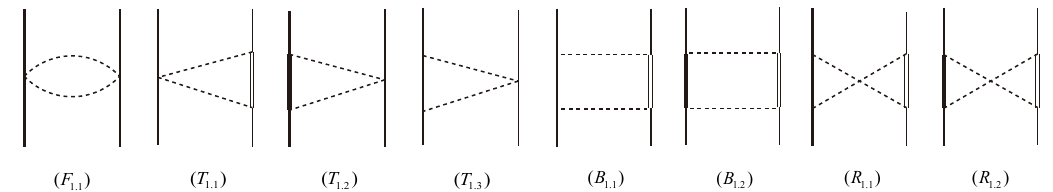
Figure 2 . The leading order Feynman diagrams that account for the O ( " 0 ) e(cid:11)ective potentials of the (cid:6) c (cid:22) D ( X 1 : 1 ), (cid:6) c (cid:22) D (cid:3) ( X 2 : 1 ; H 2 : 1 ), (cid:6) (cid:3) line to denote the (cid:22) D meson, and other notations are the same as those in (cid:12)gure 1.